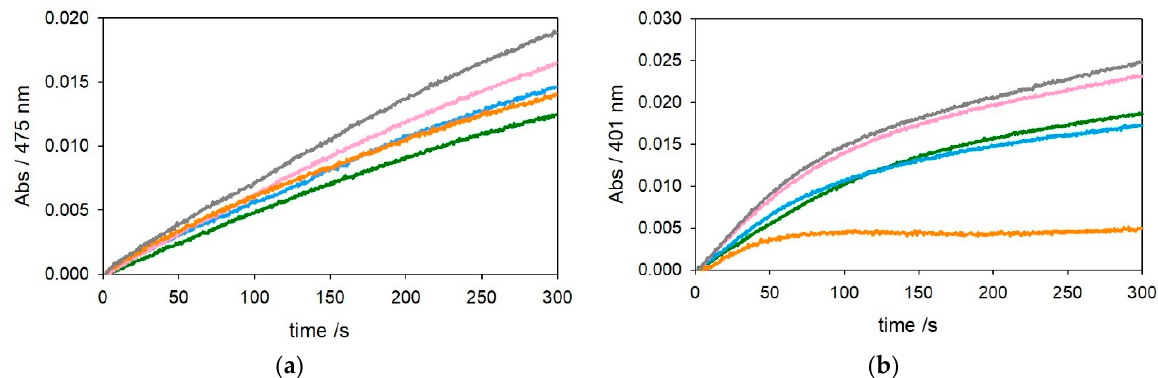
Figure 3. Kinetic profiles of DA (3 mM, panel ( a )) and MC (3 mM, panel ( b )) oxidation with time in 50 mM HEPES buffer at pH 7.4 and 20 ◦ C in the presence of Cu II alone (25 µ M, green trace) and with 1 equiv. A β 1–28 (25 µ M, pink), 2 equiv. A β 1–28 (50 µ M, grey), 1 equiv. A β 4–28 (25 µ M, light blue), and 2 equiv. A β 4–28 (50 µ M, orange).